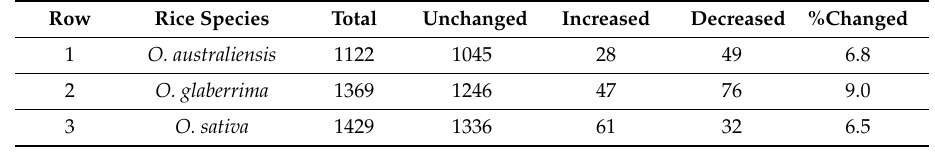
Table 3. Summary of numbers of proteins showing different levels of protein accumulation between drought stress and control conditions in three species of rice.